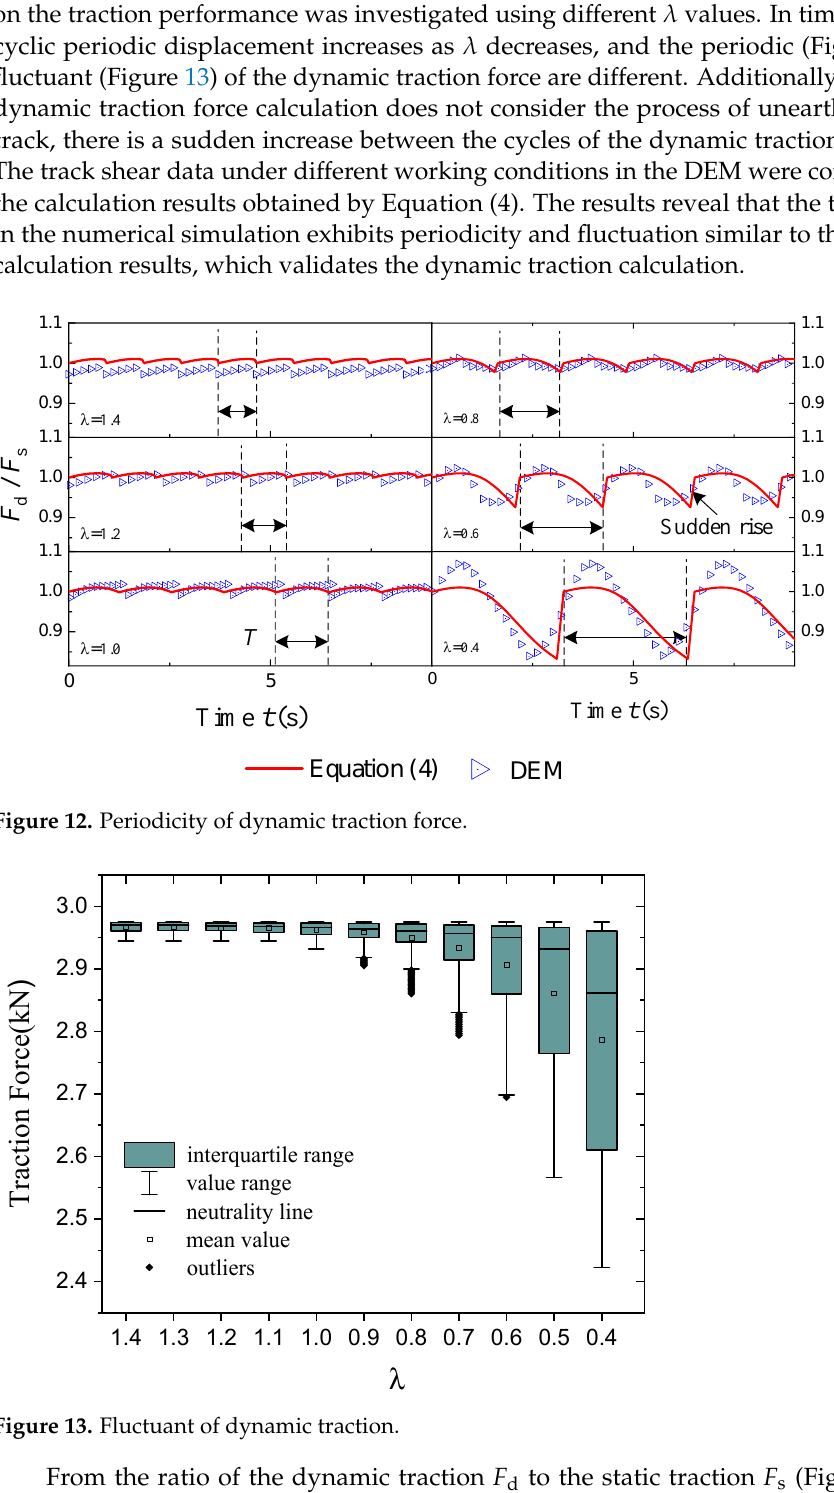
Figure 11. Comparison between F s and F d .